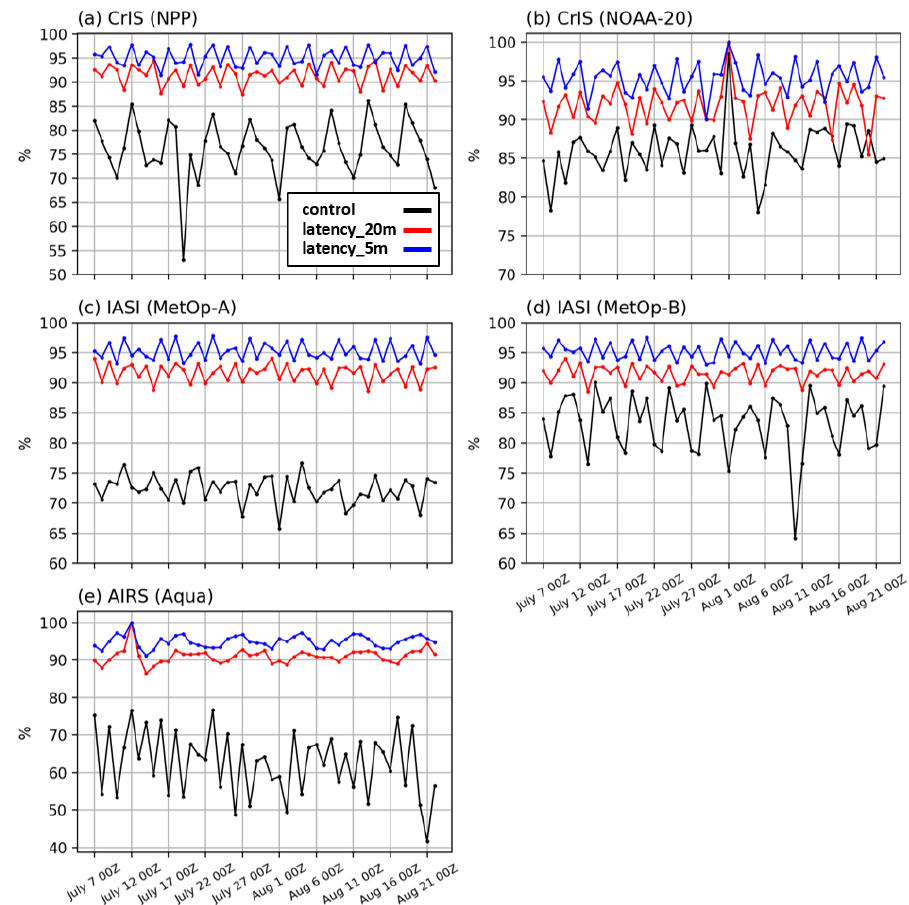
Figure 3. Time series of assimilated data ratio of ( a , b ) CrIS, ( c , d ) IASI, and ( e ) AIRS IR sounders for the period from 7 July to 22 August 2018. Black, red, and blue lines indicate the control, latency_20m, and latency_5m runs, respectively.